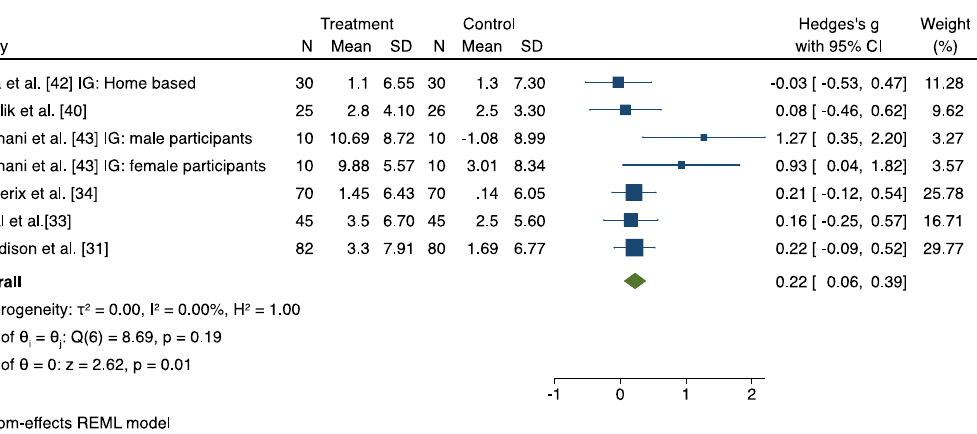
Figure 4. Results from the restricted maximum likelihood (REML) random effects meta-analysis (Hedges’ g criteria), concerning the difference in cardiorespiratory fitness (CRF) change post- intervention, between the home-based cardiac rehabilitation group (HBCR) and the center-based rehabilitation group (CBCR) [31,33,34,40,42,43].